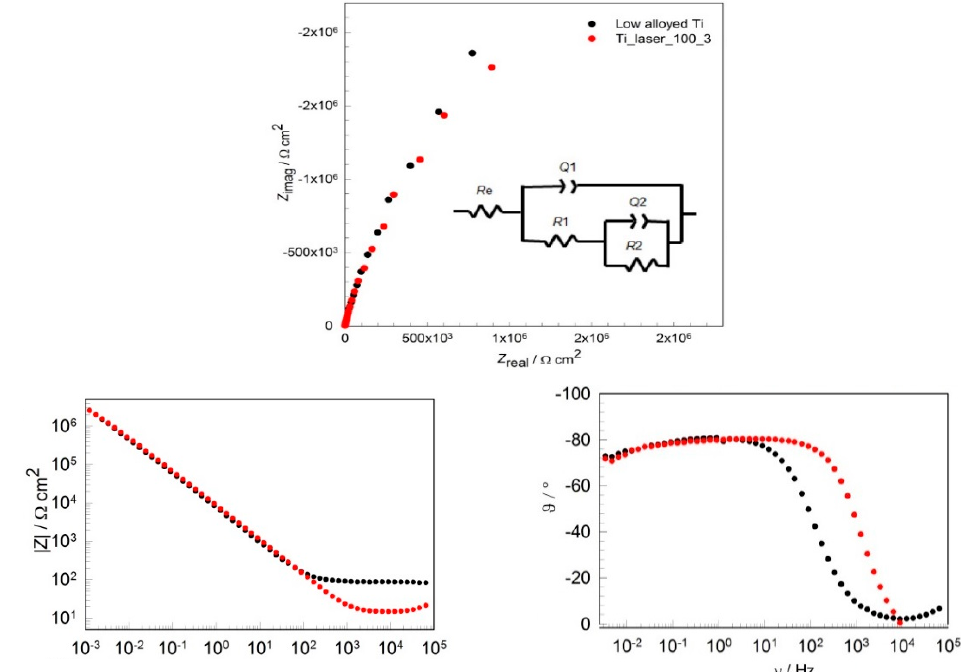
Figure 4. Nyquist and Bode plot for low alloyed Ti and laser treated surface (Ti Laser_100_3) in 0.1 M NaCl after 1.33 h immersion time at short term experiment.